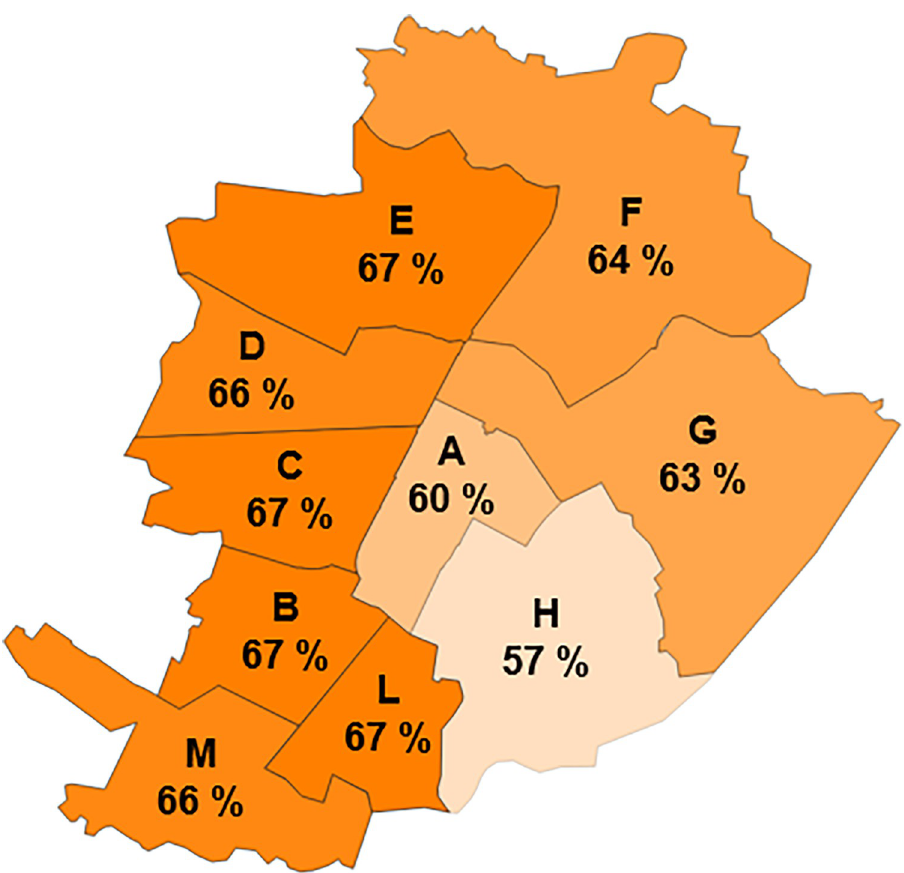
Fig 7. Domestic use of rainwater. The runoff peak reduction efficiency for each district. The map shows the mean value of 23 storm events.